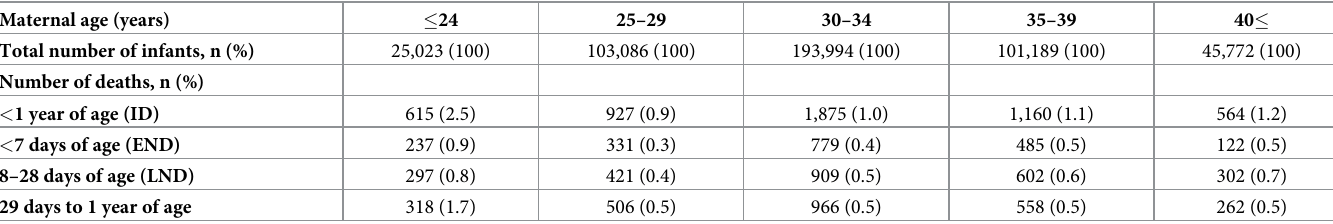
Table 5. Relationship between early neonatal death/neonatal death and maternal age.